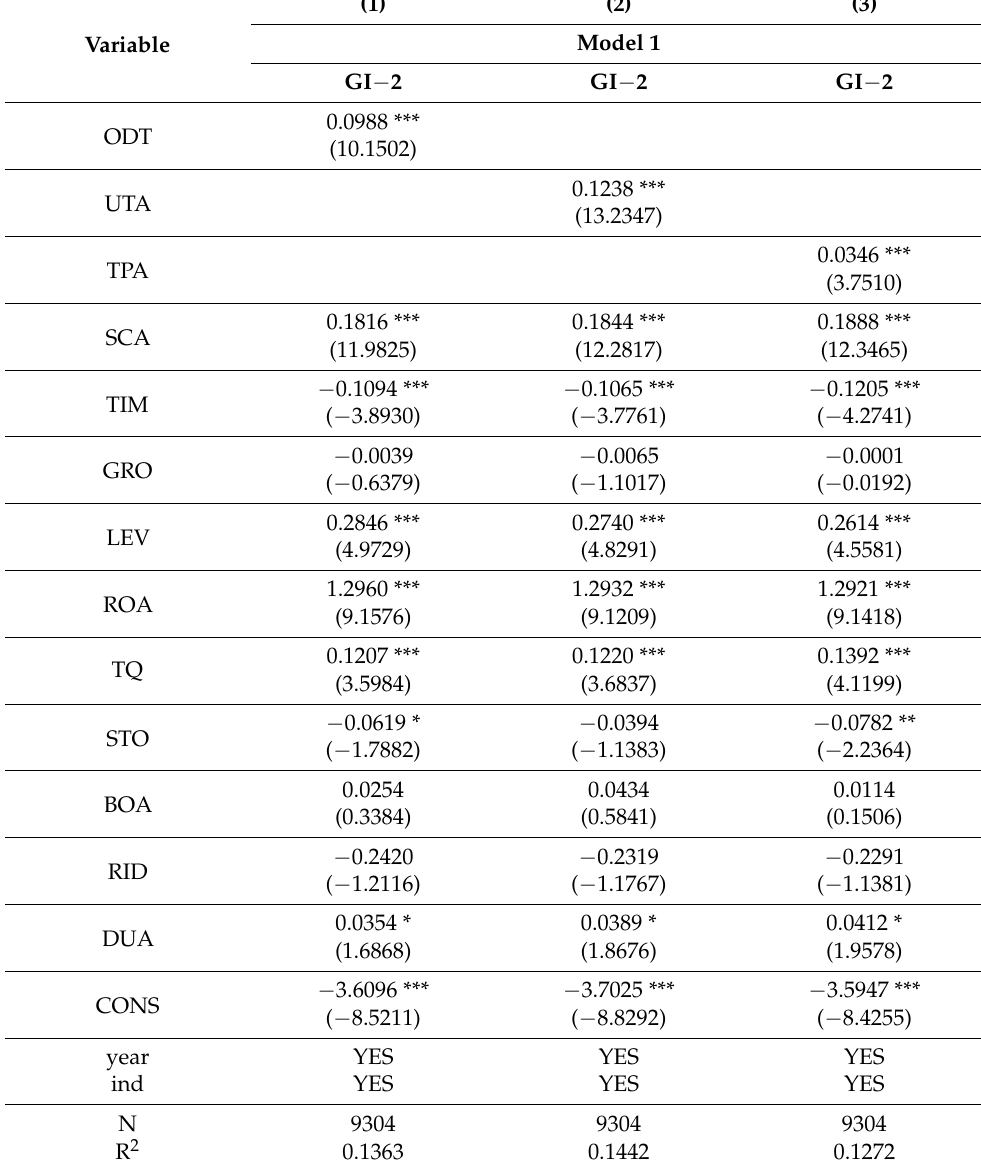
Table 11. Robustness test results